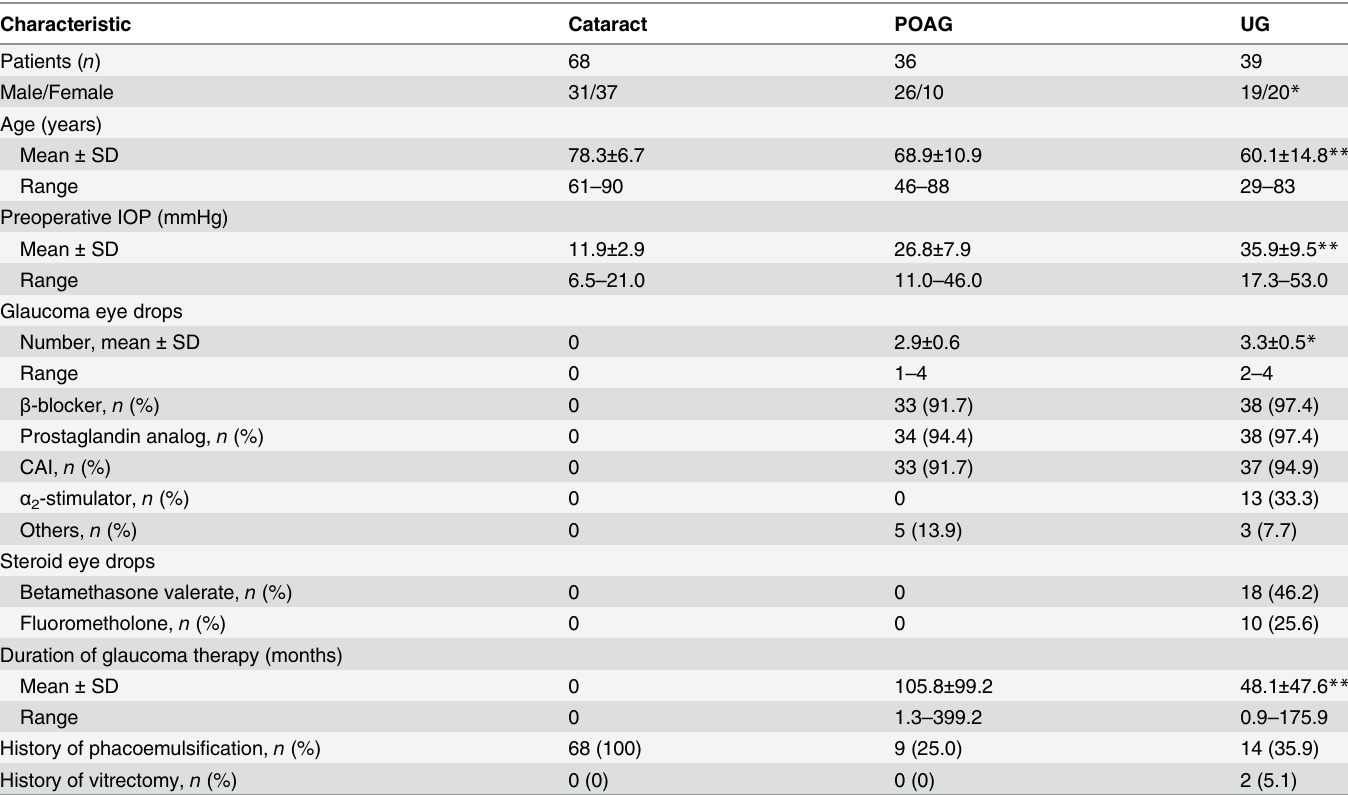
Table 1. Patient